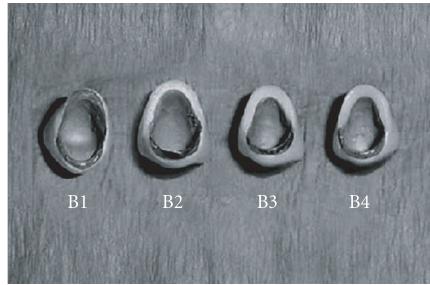
Figure 6: Fractured sample.